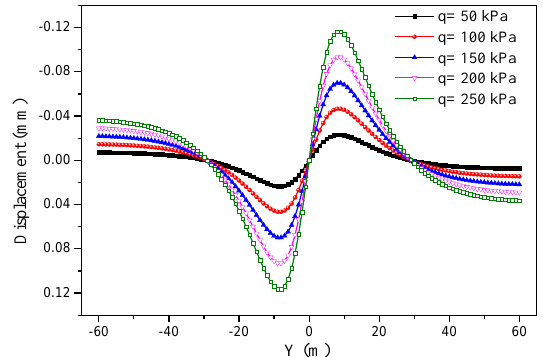
Figure 8. Longitudinal ground settlement caused by q .